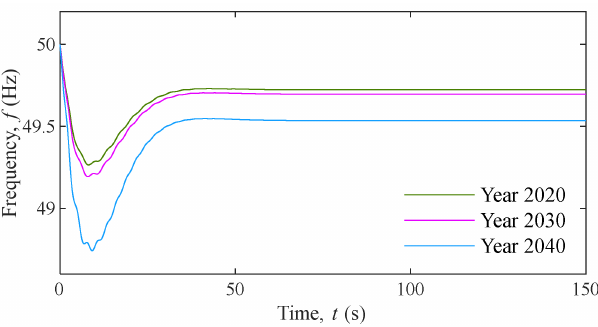
Figure 10. Comparison of the frequency response for decreasing the kinetic energy in the period 2020–2040 on Scenario